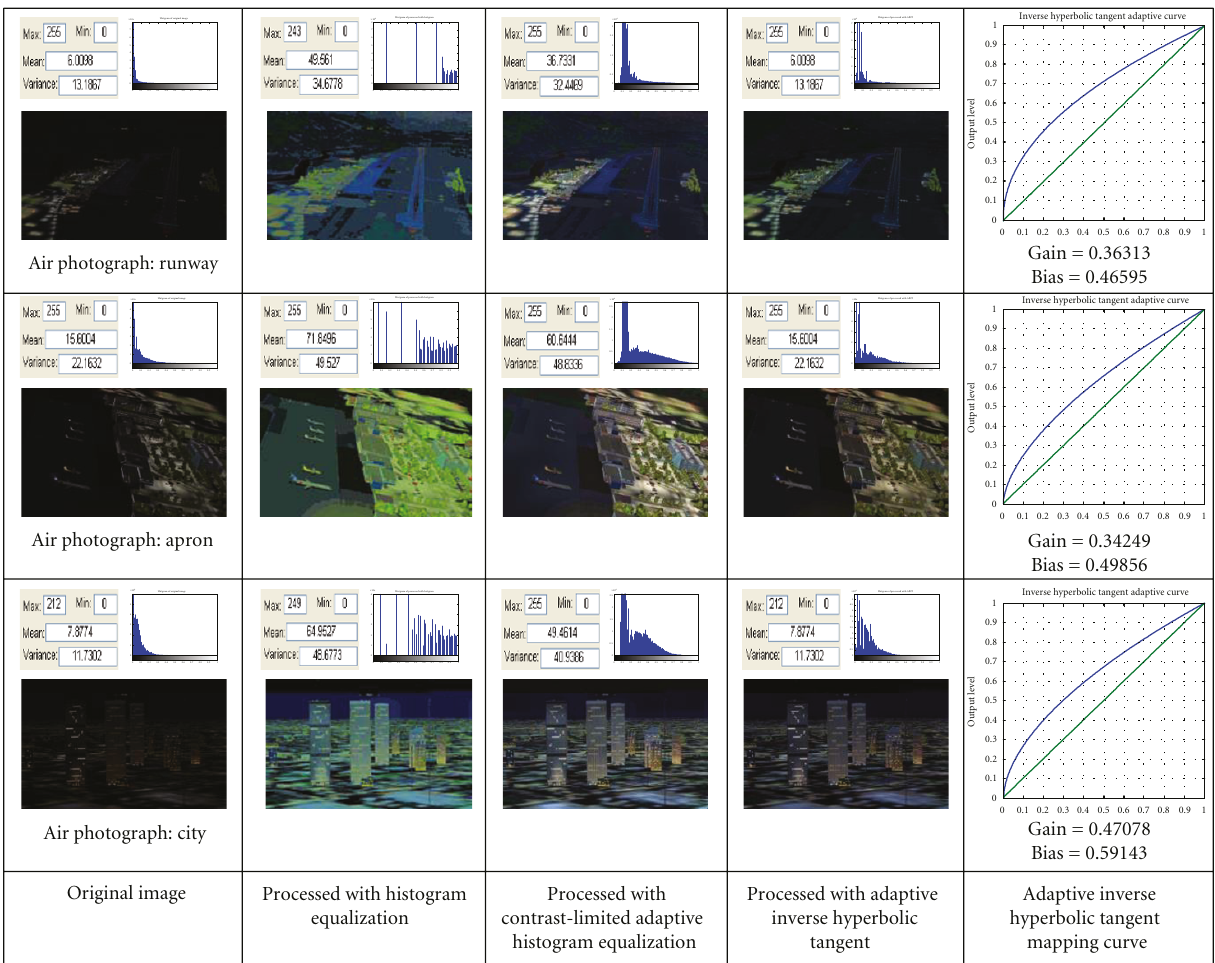
Figure 18: Various types of bad contrast images illustrating the di ff erence between contrast enhancement by histogram equalization, contrast limited adaptive histogram equalization, and our method (aerial images).